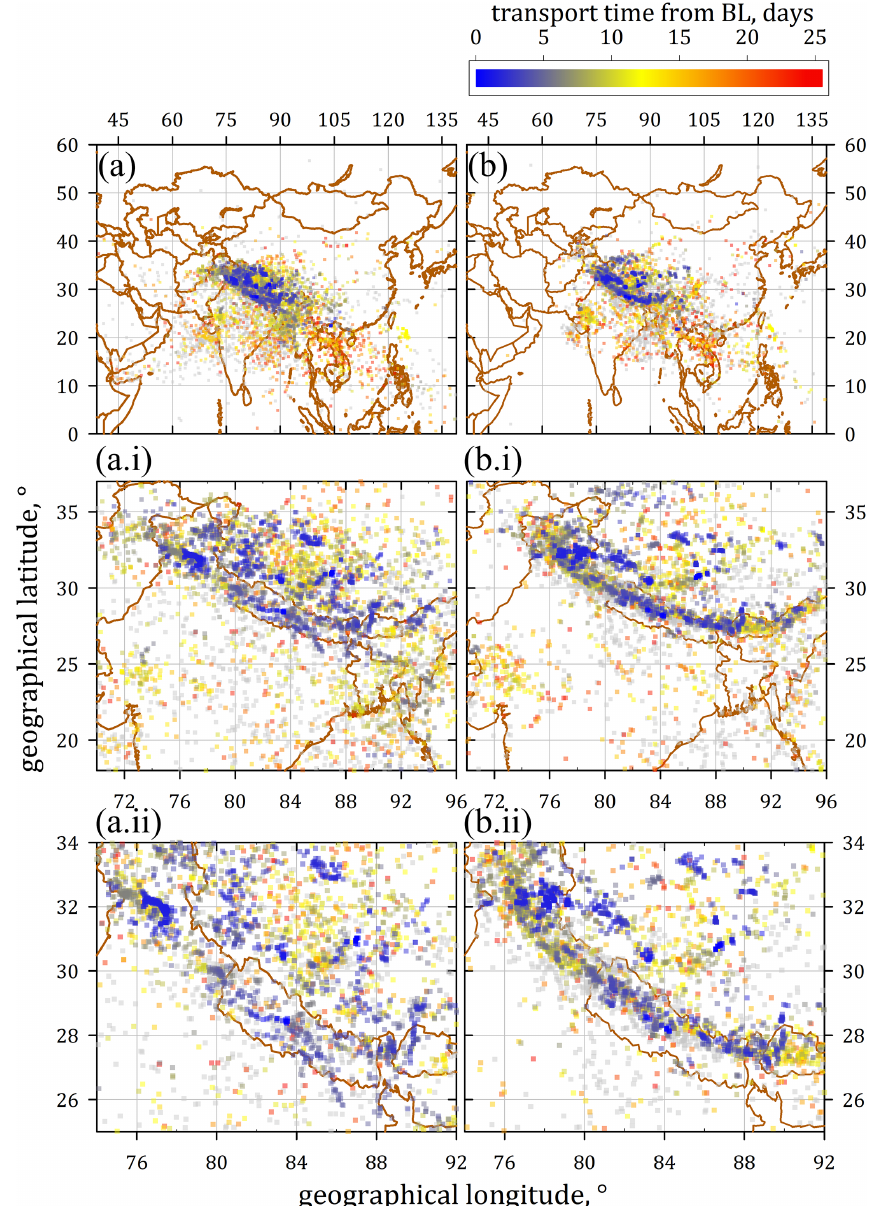
Figure 10. Structured as in Fig. 9. (a) The last boundary layer (BL) contact of the NPF-connected air mass backward trajectories. (b) The maximum ascent rate of these trajectories (for details of the trajectory analyses with ClaMS, see Fig. 9). Here, the data points are coloured to the air mass transport time since the last BL contact; grey data points indicate transport times >